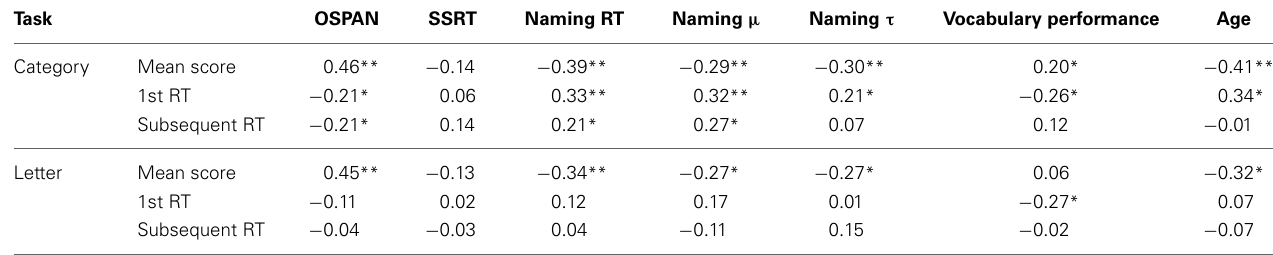
Table 3 | Relationships between the indicators (mean score, 1st and subsequent response time) of category and letter fluency performance and the individual measures (OSPAN score, SSRT, and naming response time and ex-Gaussian parameters µ and τ , vocabulary performance) and age (in years). Task OSPAN